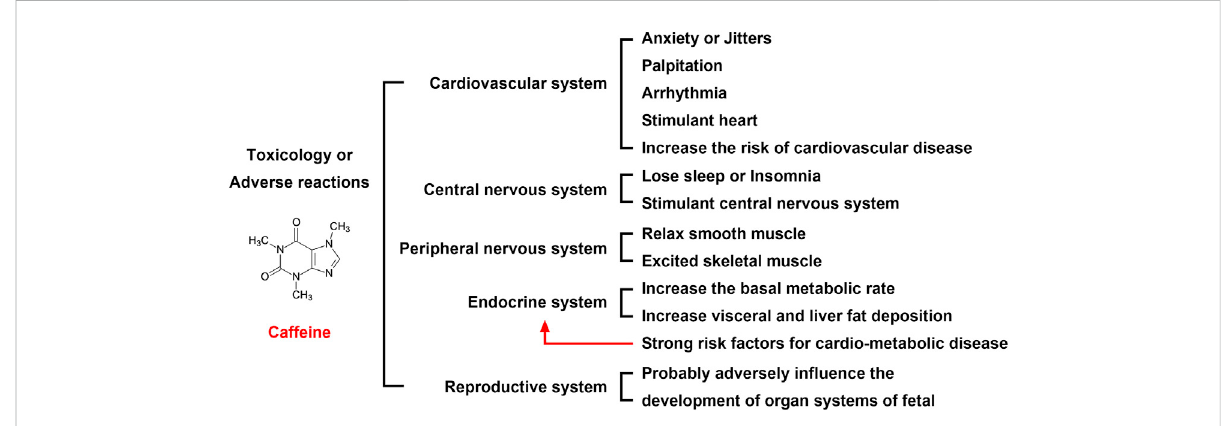
FIGURE 4 Toxicology or adverse reactions of caffeine. The adverse reactions of caffeine on the cardiovascular, nervous, and reproductive systems are serious. Although most of the adverse reactions disappear after discontinuing oral administration, the impact on the fetus is more serious, which requires expecting mothers to be vigilant. Therefore, an oral dose of coffee is not recommended for women who are trying to become pregnant or who are